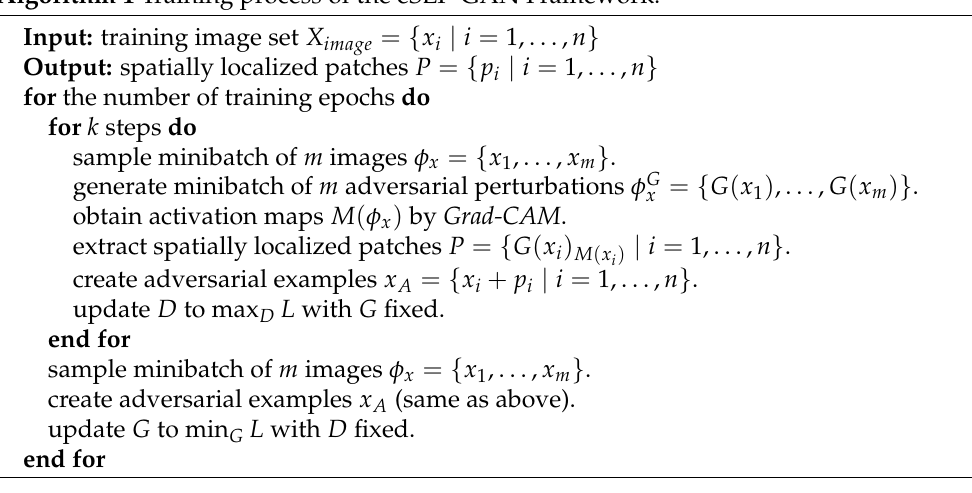
Figure 1. The eSLP-GAN framework consists of the generator G , the discriminator D , and the target model M . Algorithm 1 Training process of the eSLP-GAN